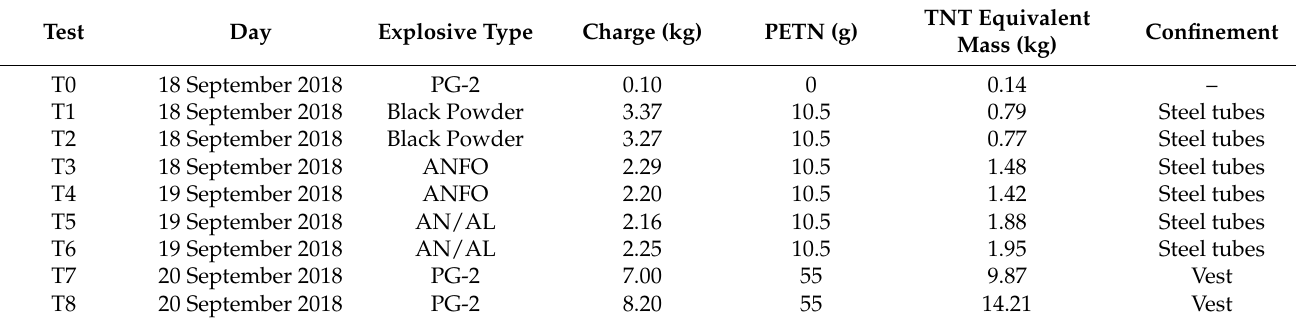
Table 1. Load characteristics during the tests carried out.